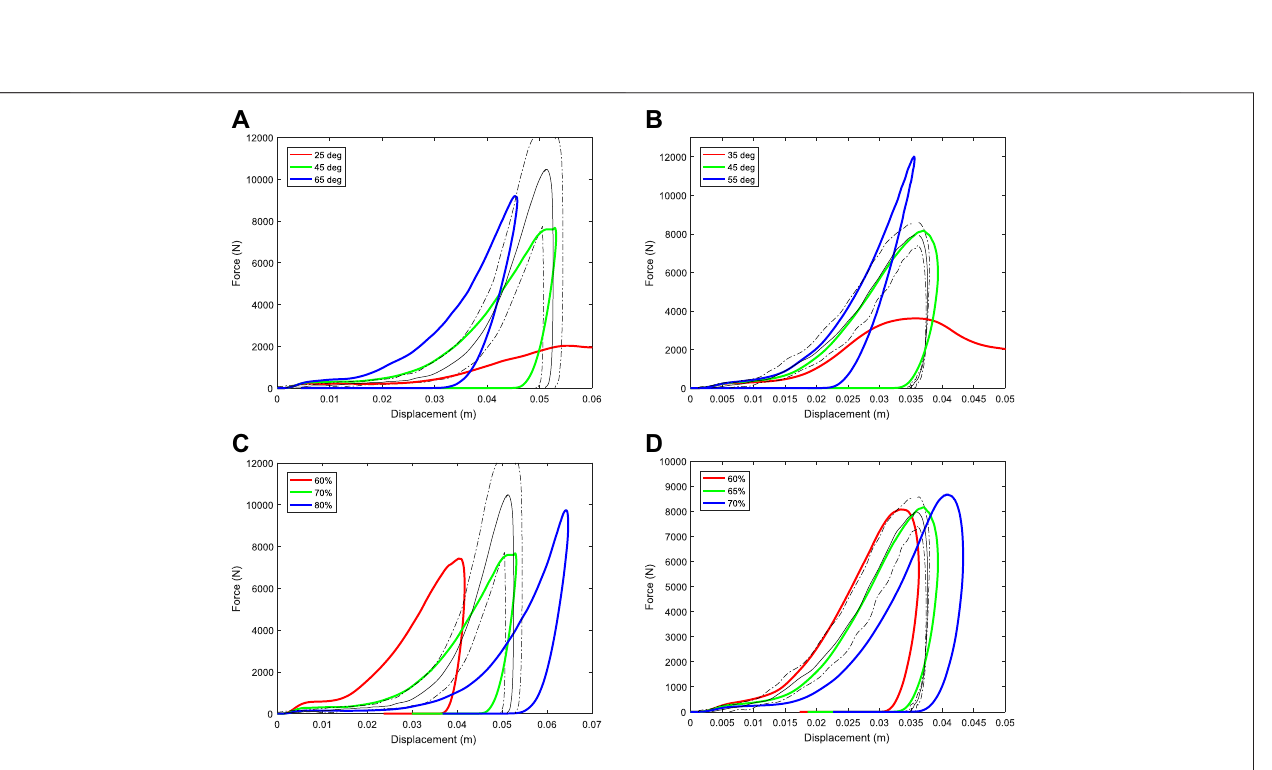
FIGURE11| Variationofforce-displacementresultsforthesimulatedtracktestingdevicewithchangesto (A,B) thefrictionangleparameterand (C,D) variationsto the void space (or the volume proportion of air) in the harrowed upper section of track of the track. Results for the dirt track are shown in the left column (a, c) for the synthetic track are shown in the right column (b,